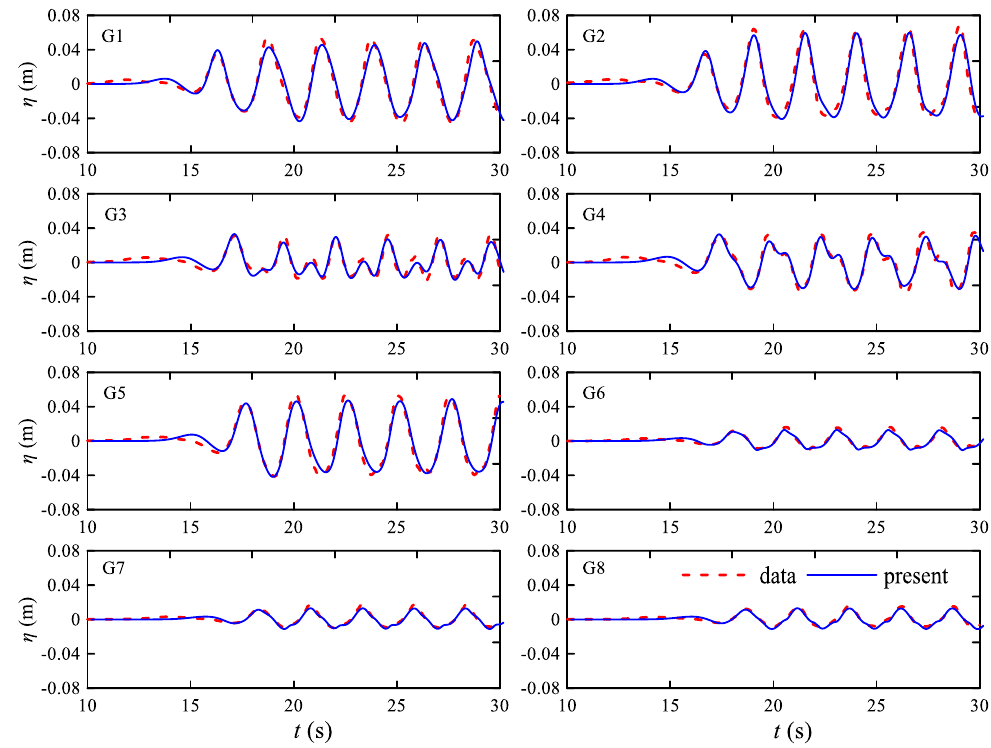
Figure 9. Time series of surface elevation for regular wave propagation in porous structure (Case R3).